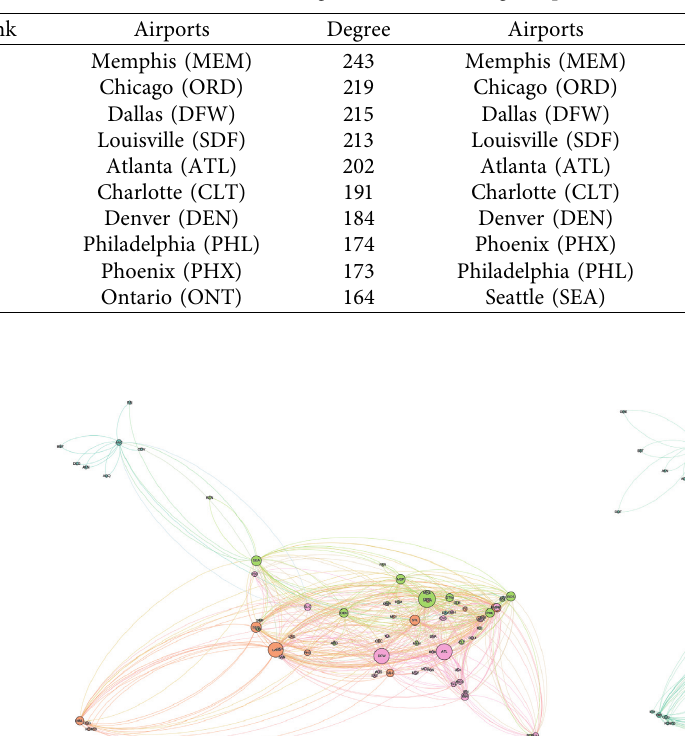
Table 5: Rankings of the US air cargo airports based on complex network metrics in